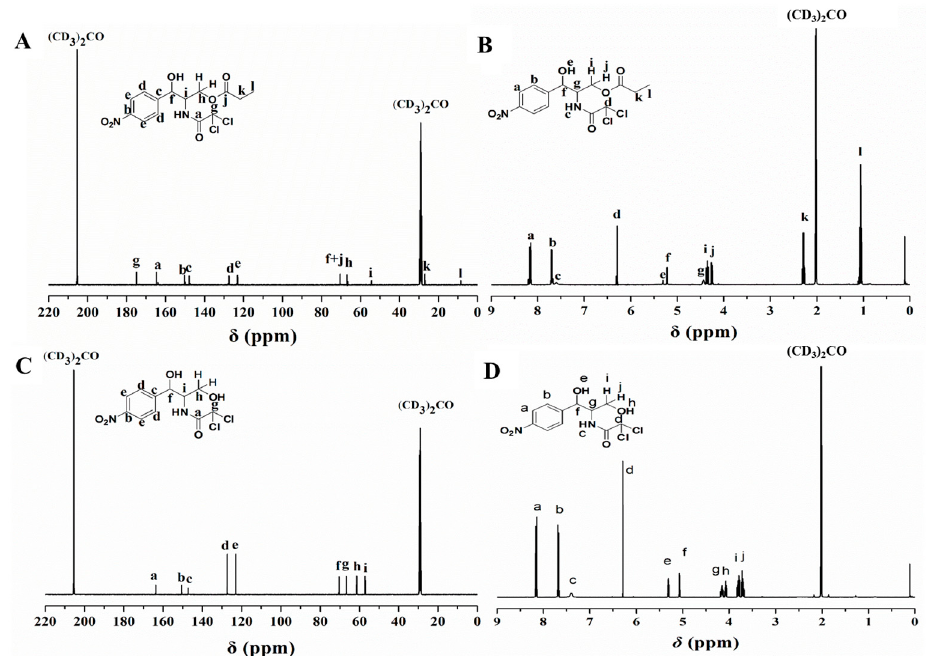
Figure 1. NMR spectra of chloramphenicol propionate ester and chloramphenicol. ( A ) 13 C-NMR spectrum of chloramphenicol propionate ester in (CD 3 ) 2 CO; ( B ) 1 H-NMR spectrum of chloramphenicol propionate ester in (CD 3 ) 2 CO; ( C ) 13 C-NMR spectrum of chloramphenicol in (CD 3 ) 2 CO; ( D ) 1 H-NMR spectrum of chloramphenicol in (CD 3 ) 2 CO.